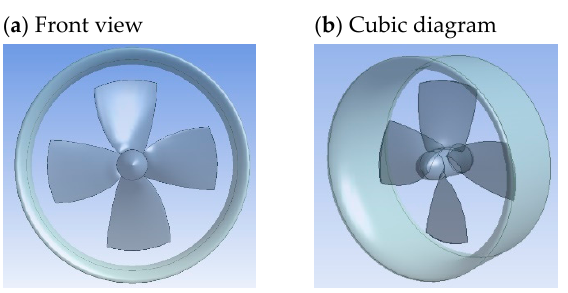
Figure 9. Geometrical model of the ducted propeller. ( a ) Front view; ( b ) Cubic diagram. The coordinate system was defined uniformly here, as shown in Figure 10b: the di- rection of the z -axis was defined as the forward and backward direction of the underwater robot, where the positive value was forward and the negative value backward. The Y di- rection was the left and right direction of the underwater robot, where the positive value was right and the negative value was left. The X direction was the heave direction of the underwater robot, where the positive value was rising and the negative value was sinking. Table 7. Primary parameters of the ducted propeller.